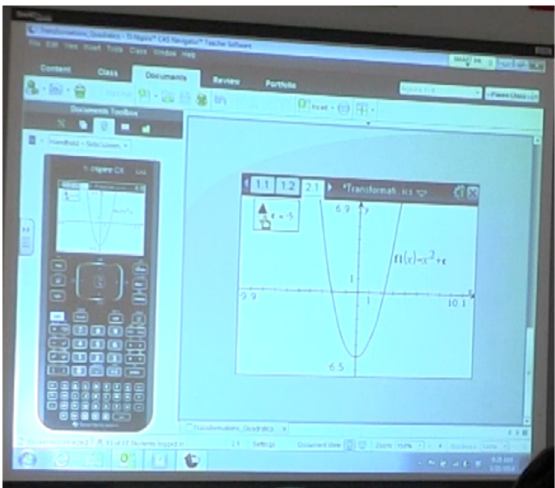
Figure 1. Image of Ms. Joiner’s computer screen emulating the student’s graphing calculator on Day 1 (21 February).